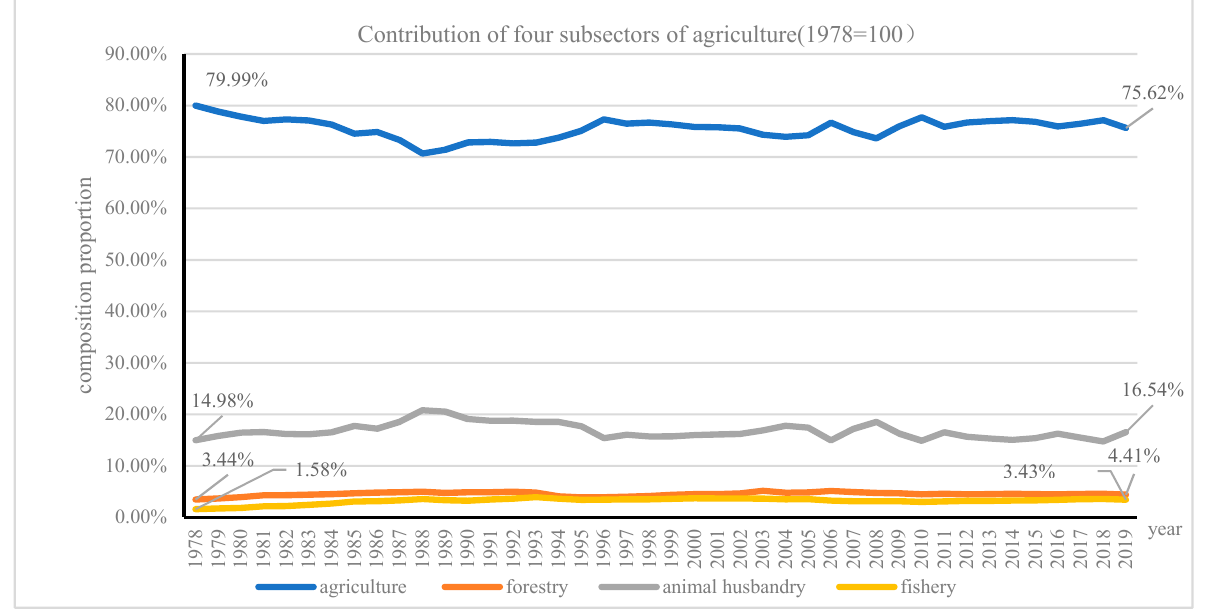
Figure 10. Contribution of four subsectors of agriculture measured at price of 1978. Although increasing uncertainties about the climate and negative impacts arising from agricultural intensification have put into question the “specialization—higher productivity” path of development, the same tendency has emerged in agroecosystems in less developed regions to achieve market competitiveness of specialization at the farm level. It is believed that gains from specialization and regional comparative advantage have not been fully achieved in China [87]; the regional patterns of China’s grain production are far from representing regional comparative advantage [88,89]—this is partly proved by our study. subsectors has not changed much (see Figure